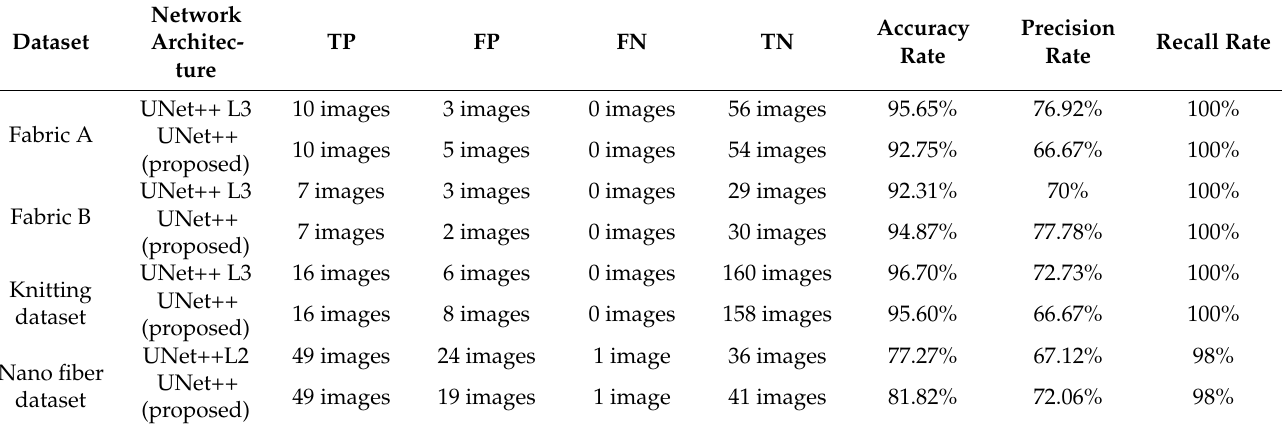
Table 6. Image-level defect judgment